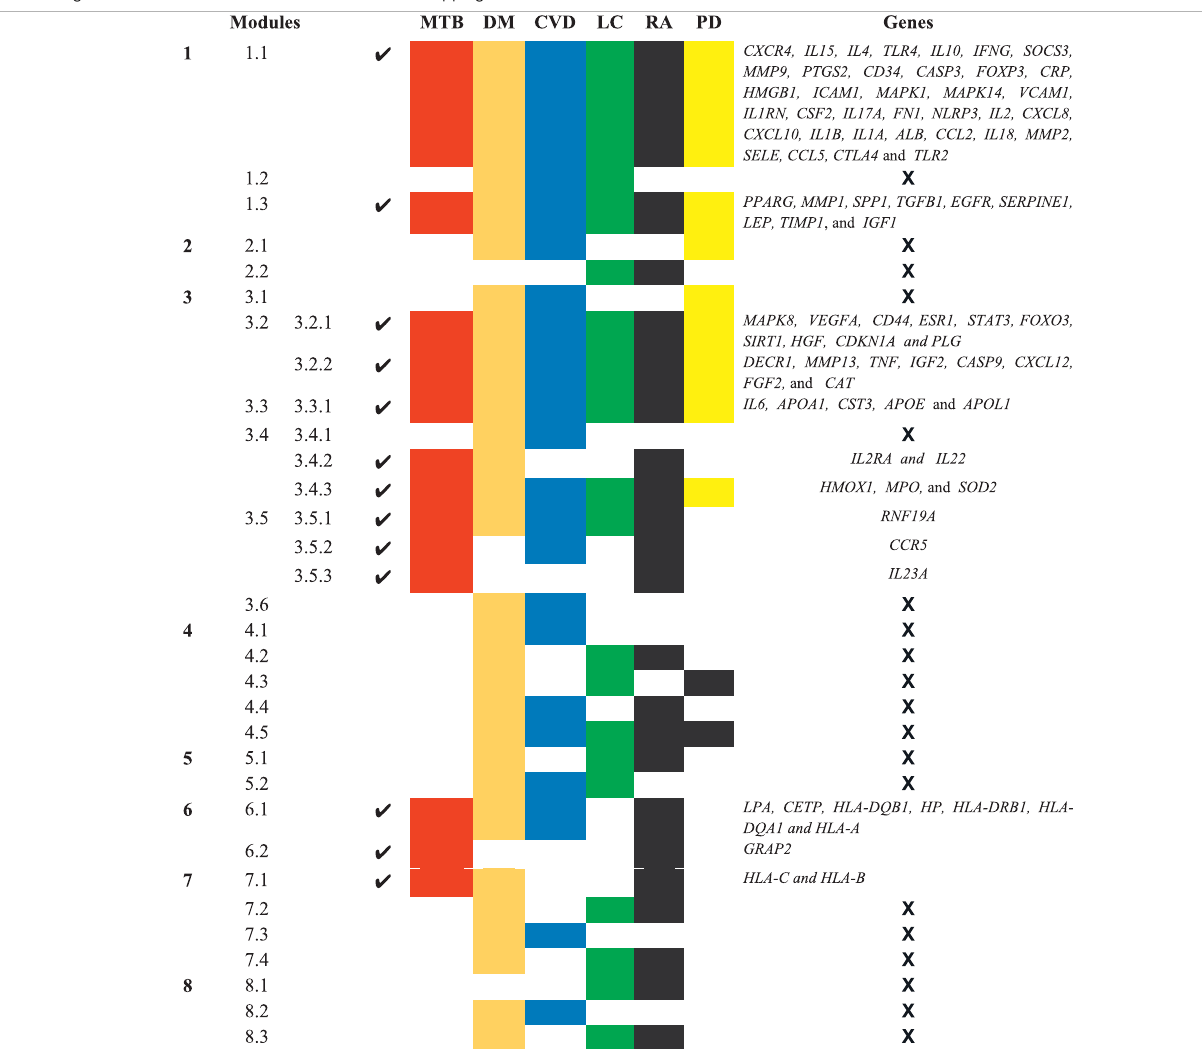
TABLE 2 | List of 13 Modules and Sub-Modules which contain hub genes of Disease (MTB, DM, CVD, LC, RA, and PD) but we only considered those modules ( ✔ ) which have hub genes that are common in MTB as well as overlapping NCDs.